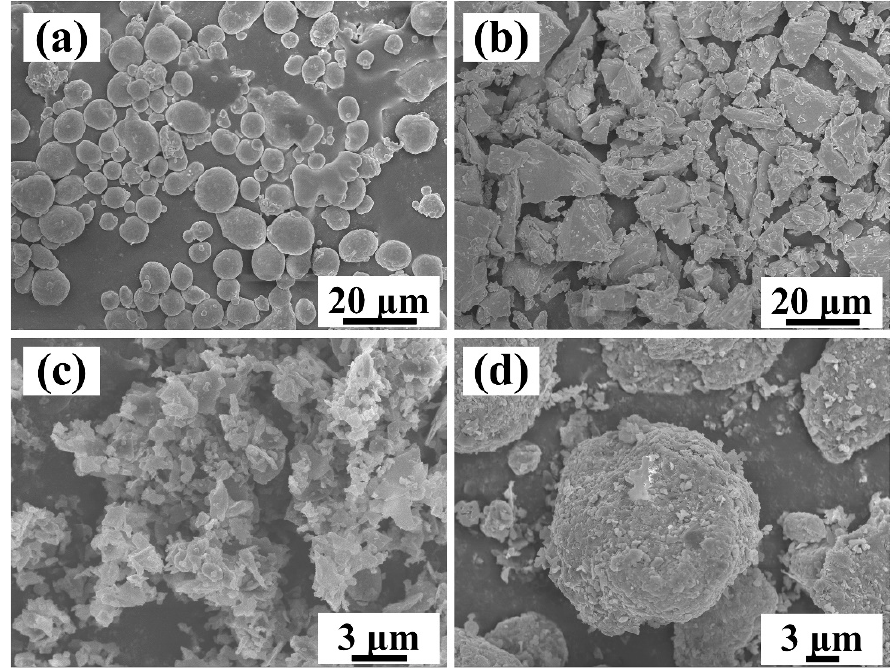
Figure 1. SEM images of ( a ) Al-Cu-Mg-Si alloy powder, ( b ) Ti powder ( c ) B 4 C powder and ( d ) mixed powders of Al, Ti and B 4 C powders after ball-milling.